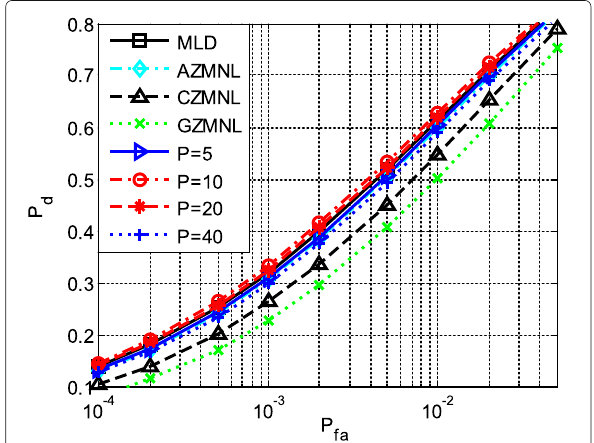
Fig. 7 Detection probability versus P fa in real atmospheric noise, for GSNR = − 18 dB. Except the PZMNLs, other detectors make the assumption of S α S